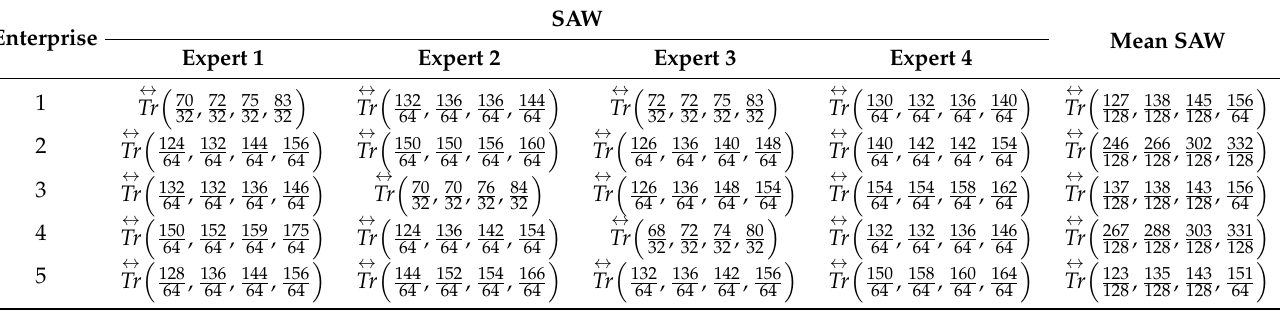
Table 3. Simple Additive Weighting (SAW) and Mean SAW levels. SAW